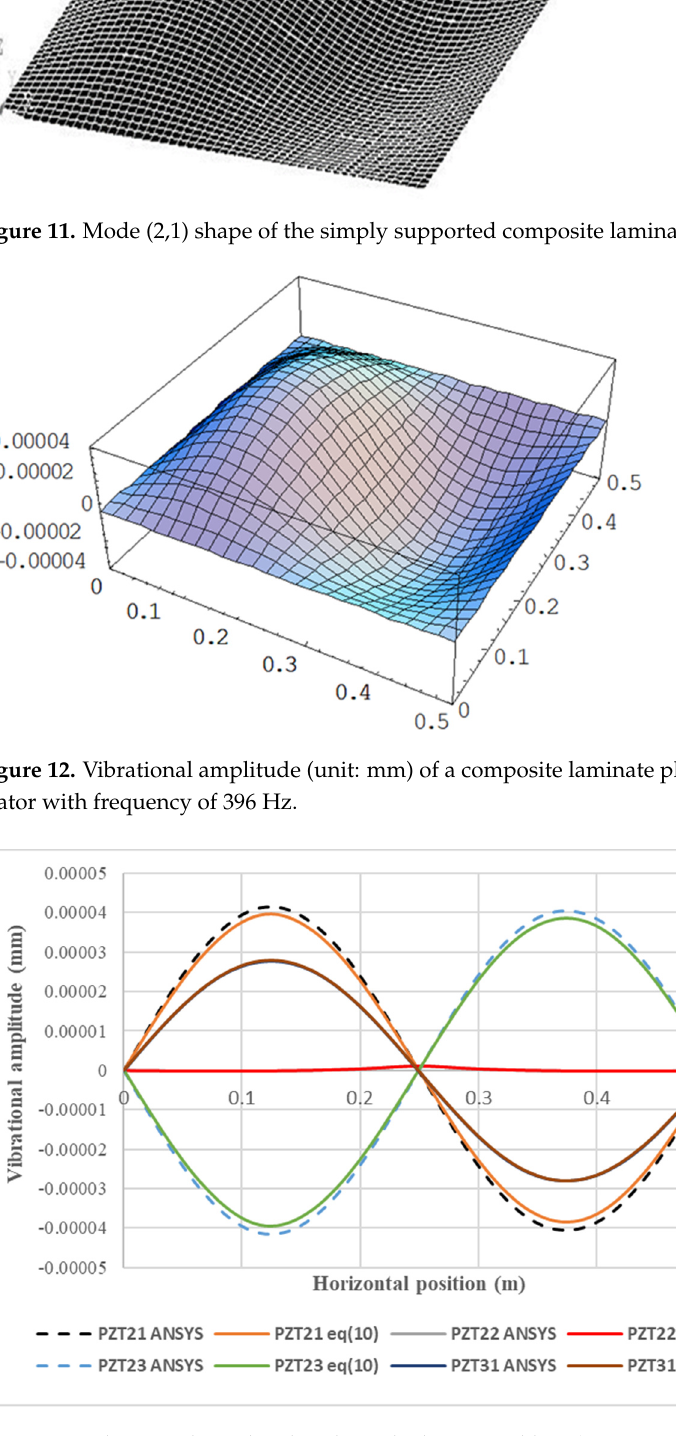
Figure 13. Vibrational amplitudes along the horizontal line (y = 0.25 m) of the composite laminate plate excited by the PZT 21, PZT 22, PZT 23, and PZT 31 actuators.